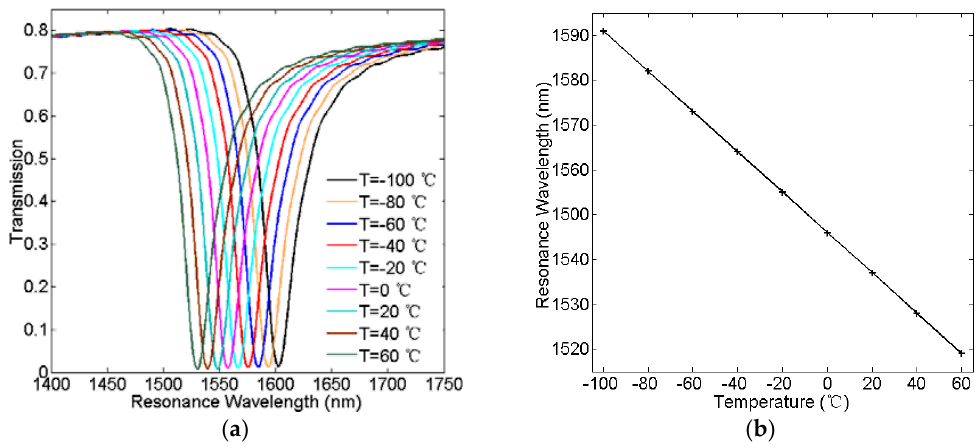
Figure 8. ( a ) Simulated transmission spectra of the temperature ‐ sensing structure with different temperatures T ; ( b ) Resonance wavelength versus the temperature T .